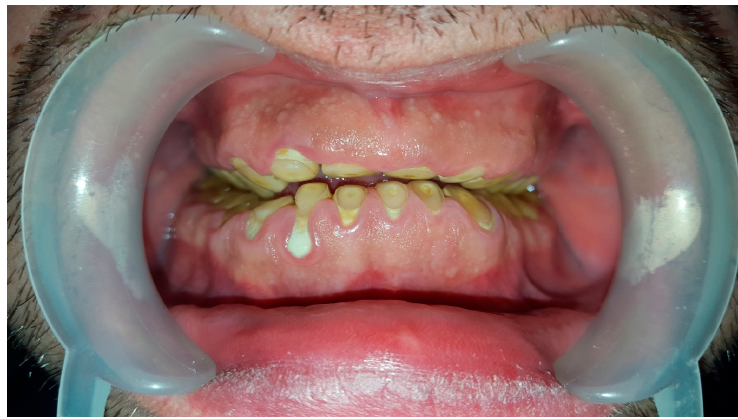
Figure 2. Tooth wear in presented bruxist patient.